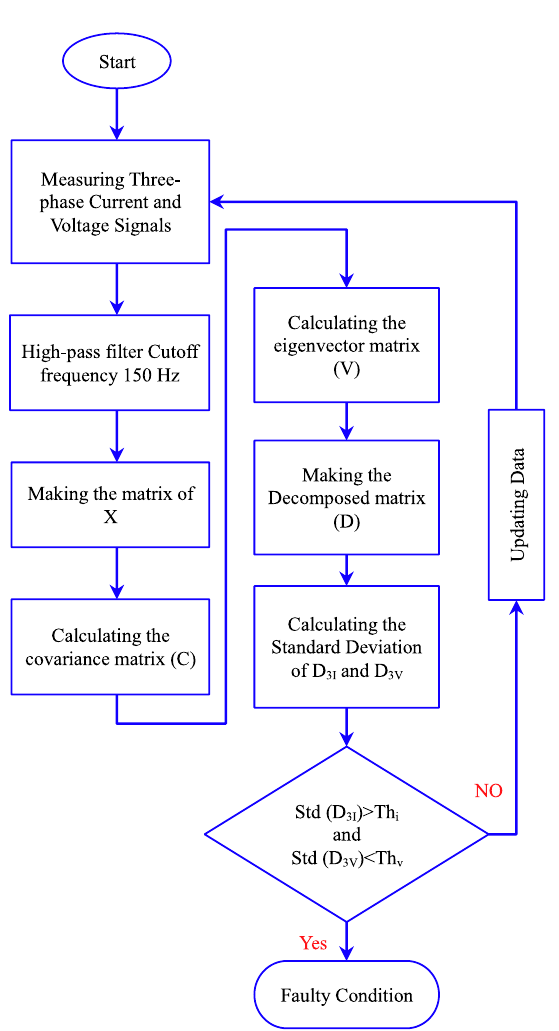
Fig. 6 The flowchart of the proposed method